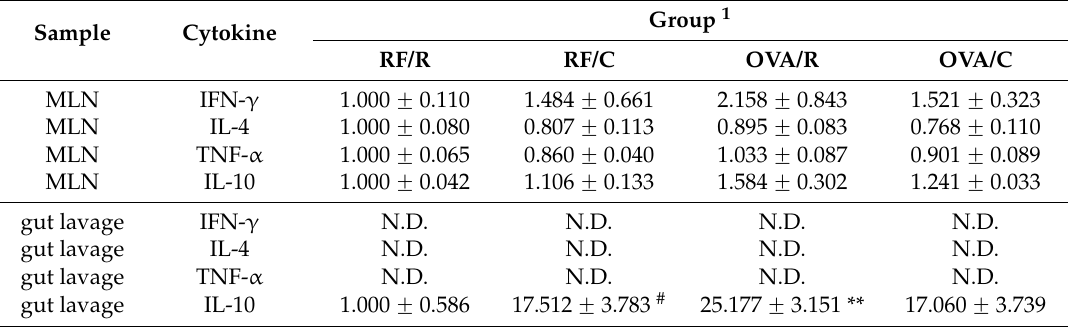
1 Groups: RF/R (reference group: vehicle and AIN-93M diet); RF/C (reference cocoa group: vehicle and 10% cocoa diet); OVA/R (sensitized group: OVA plus CT and AIN-93M diet); and OVA/C (sensitized cocoa group: OVA plus CT and 10% cocoa